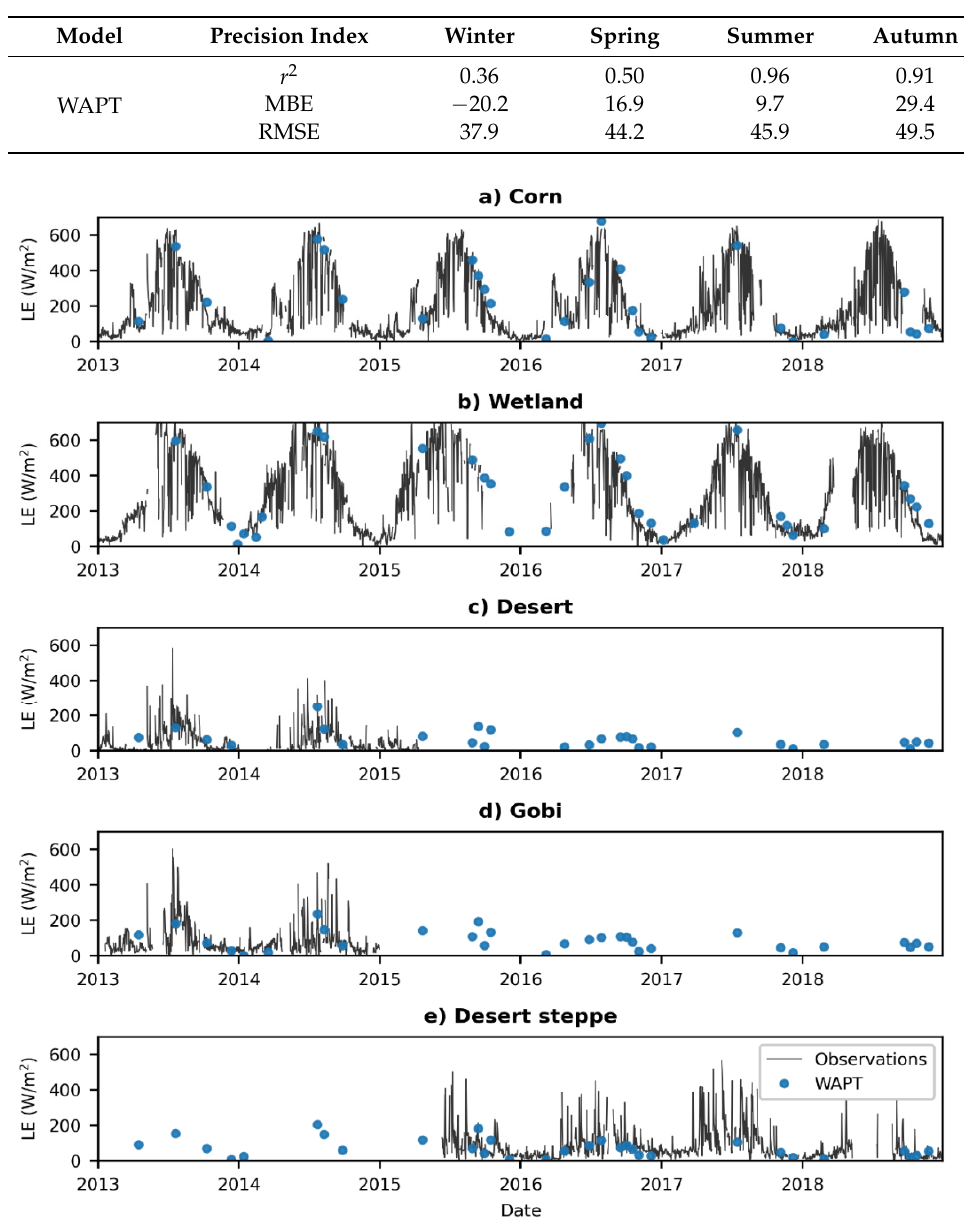
Figure 4. Variations of estimated LE with the WAPT model over different landcovers compared with observed data: ( a ) corn (Daman); ( b ) wetland (Zhangye); ( c ) Desert (Shenshawo); ( d ) Gobi (Bajitan), and ( e ) Desert steppe (Huazhaizi). The blue points represent estimated LE from the WAPT model. The black lines are the observed LE during 2013–2018.